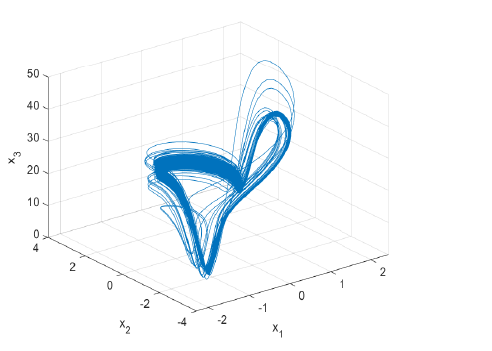
Figure 12. System (1) is periodic for a = 10, c = 8/3, d = 0.1, and b = 14.8.